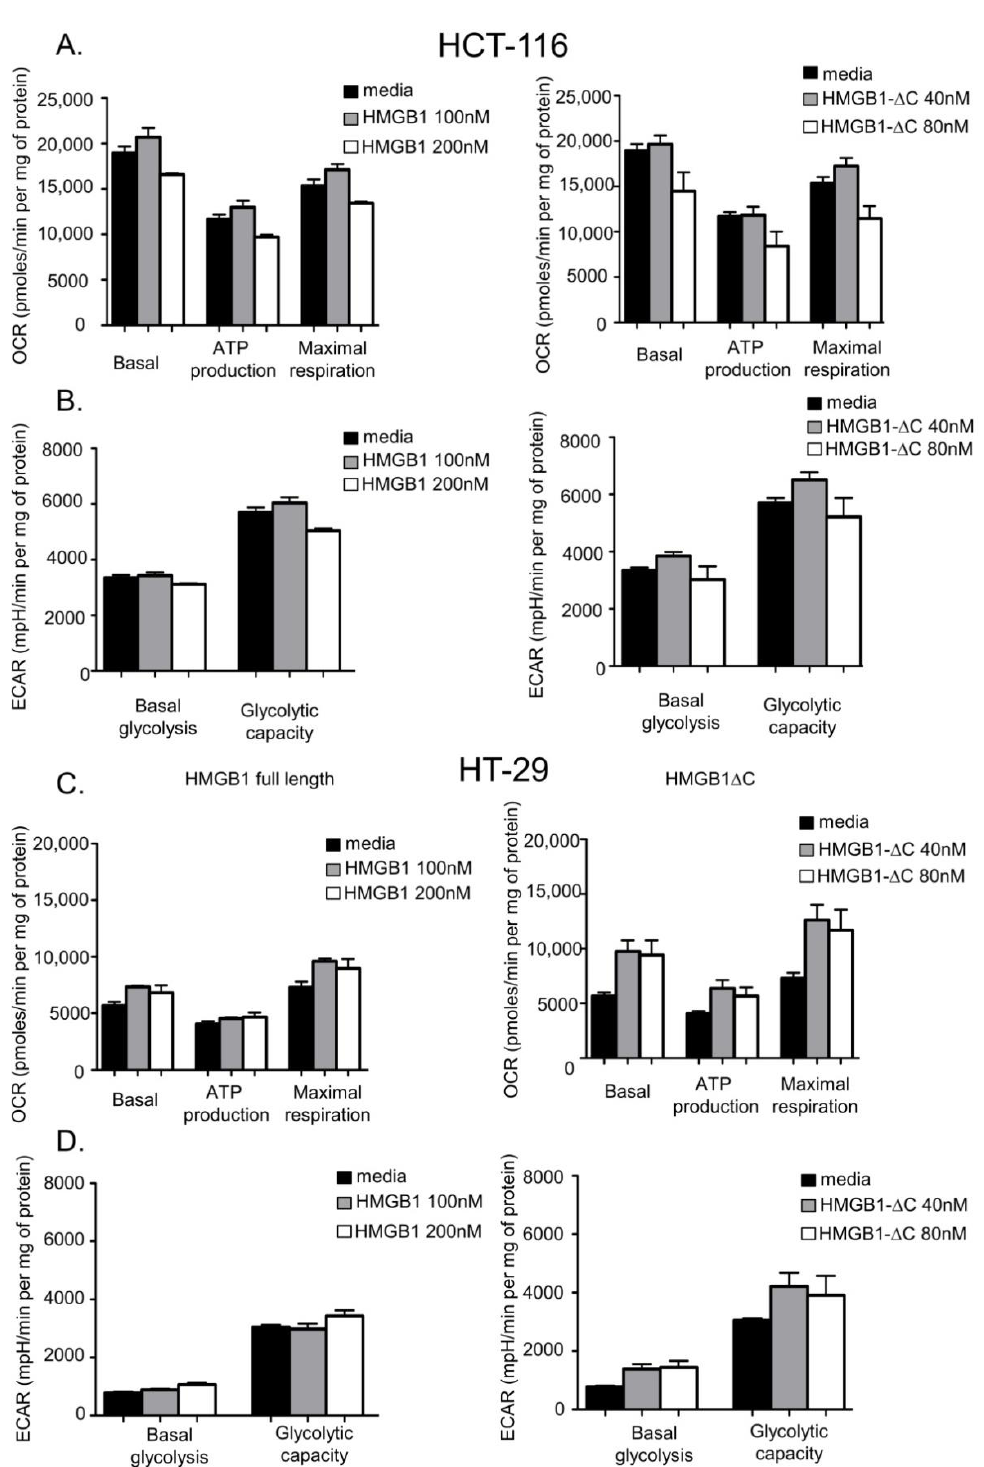
Figure 7. Acute effects of increasing concentrations of HMGB1-fl and HMGB1- ∆ C on HCT-116 ( A , B ) and HT-29 ( C , D ) cell bioenergetics. ( A ) HCT-116 cells were seeded in a Seahorse XFe24 plate, treated for 48 h with HMGB1-fl (left panel) or HMGB1- ∆ C (right panel) and basal OCR measurements were made followed by injection of oligomycin (1 µ M), FCCP (1 µ M) and rotenone (10 µ M) + antimycin A (10 µ M). ATP linked respiration is the difference in OCR before and after oligomycin injection. Maximal respiration is defined as the OCR after FCCP injection. Non mitochondrial respiration was determined after rotenone + antimycin A injection. The rates of basal respiration, ATP-linked respiration and maximal respiratory capacity were normalized with the total amount of proteins present in each well. OCR is expressed in pmoles per min per mg of protein. The data